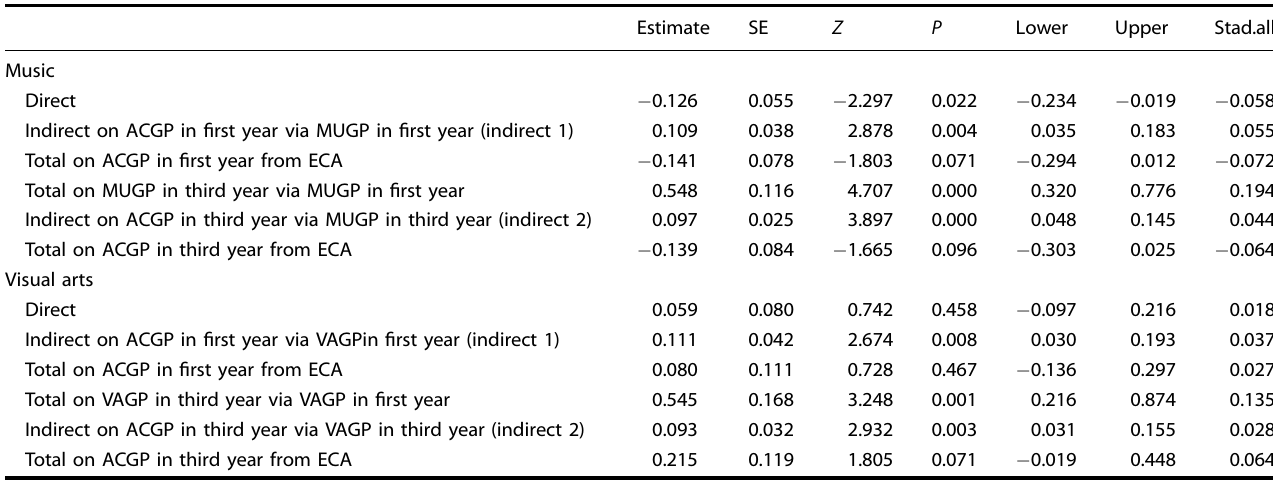
Table 3. Standardized direct, indirect, and total effects for all variables in the model.